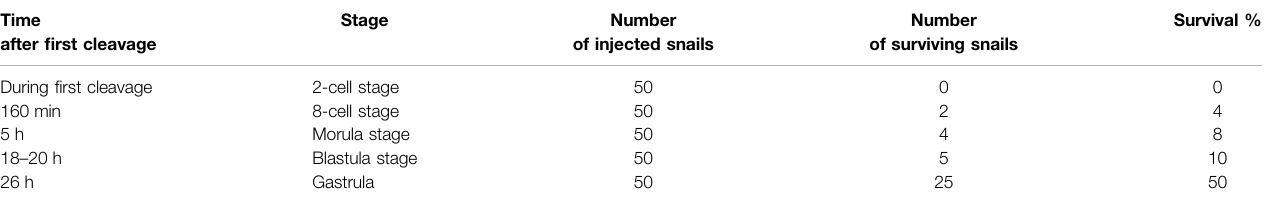
TABLE 5 | Survival percentages of the transfections done at different embryo developmental stages with the in vivo jetPEI reagent. Time after fi rst